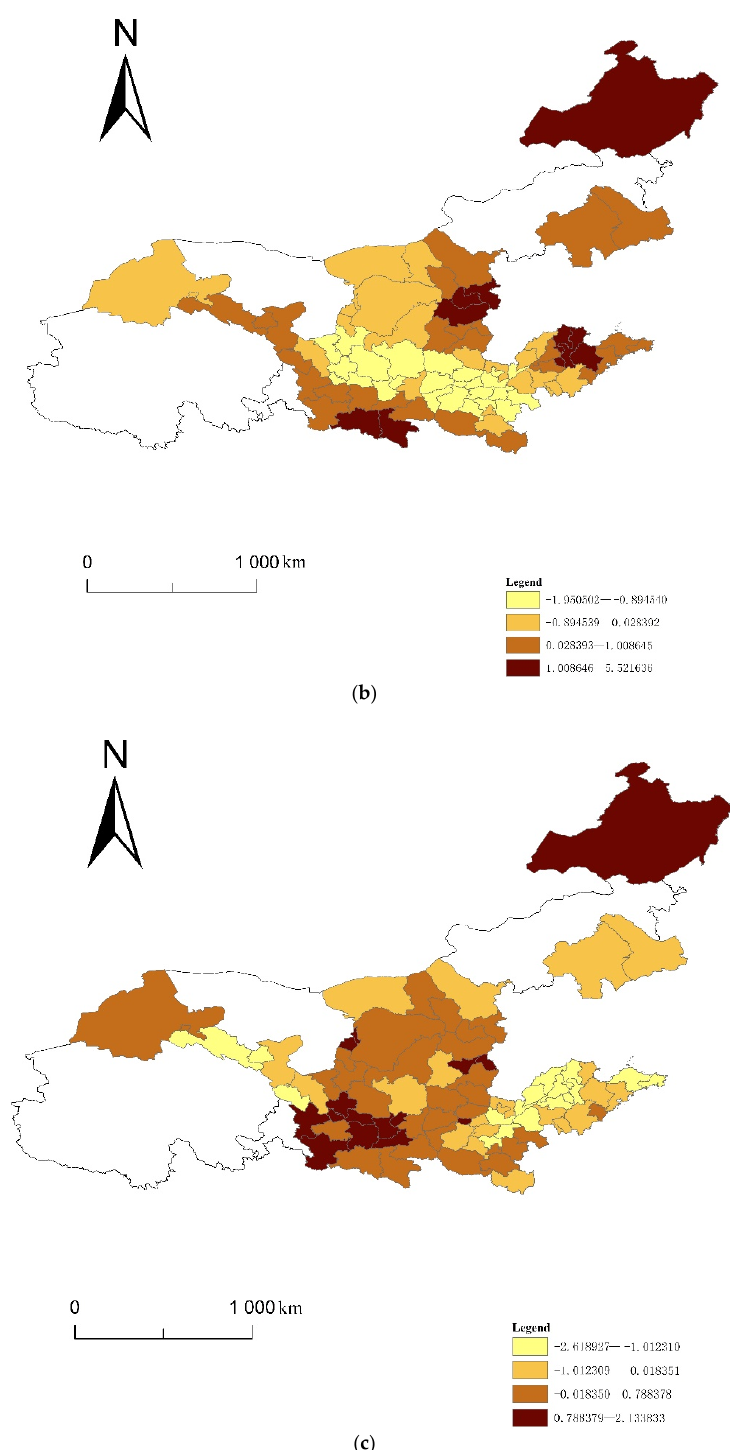
Figure 5. ( a ) Cold–hot evolution diagram of the UECC in the YRB in 2008. ( b ) Cold–hot evolution diagram of the UECC in the YRB in 2012. ( c ) Cold–hot evolution diagram of the UECC in the YRB in 2017.